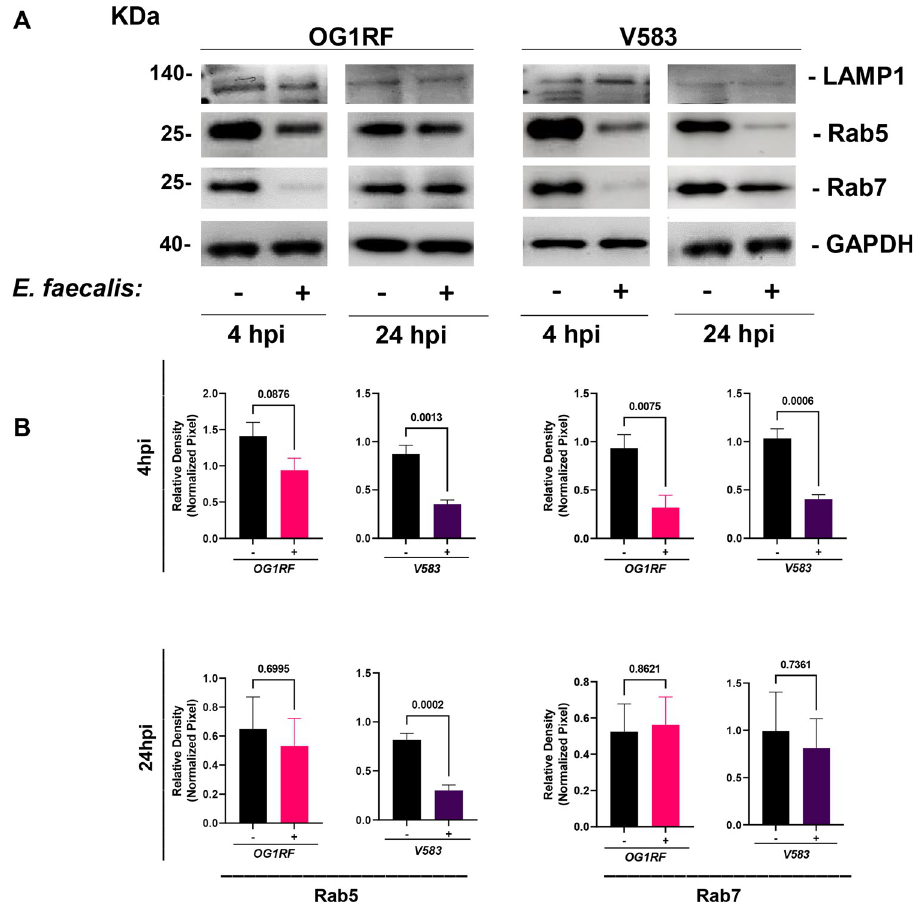
Fig 6. E . faecalis infection reduces keratinocyte expression of both Rab5 and Rab7 at 4 hpi. (A) Whole cell lysate analyzed by immunoblotting with antibodies α -LAMP1 (polyclonal antibody), α -Rab5, α -Rab7 and α -GAPDH. HaCaT cells were incubated with (+) and without (-) E . faecalis OG1RF and V583 for 4 hpi and 24 hpi. Images shown are representative of at least 3 biological replicates. (B) Relative density of the bands of interest were normalized against loading control (GAPDH). Error bars represent biological replicates and mean ± SEM from at least 4 independent experiments. Statistical analysis was performed using unpaired T-test with Welch’s correction.